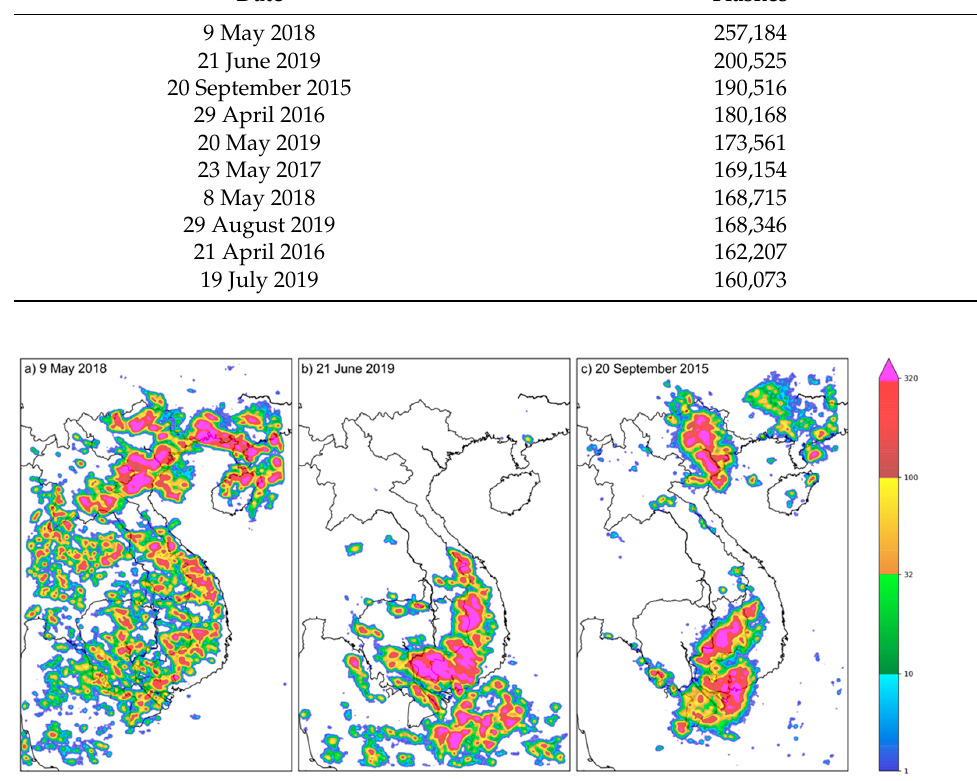
Figure 9. Lightning density maps for the three most lightning-abundant days in the study period: ( a ) 9 May 2018 (257,184 flashes), ( b ) 21 June 2019 (200,525 flashes), and ( c ) 20 September 2015 (190,516 flashes). The values are flashes 100 km − 2 day − 1 .